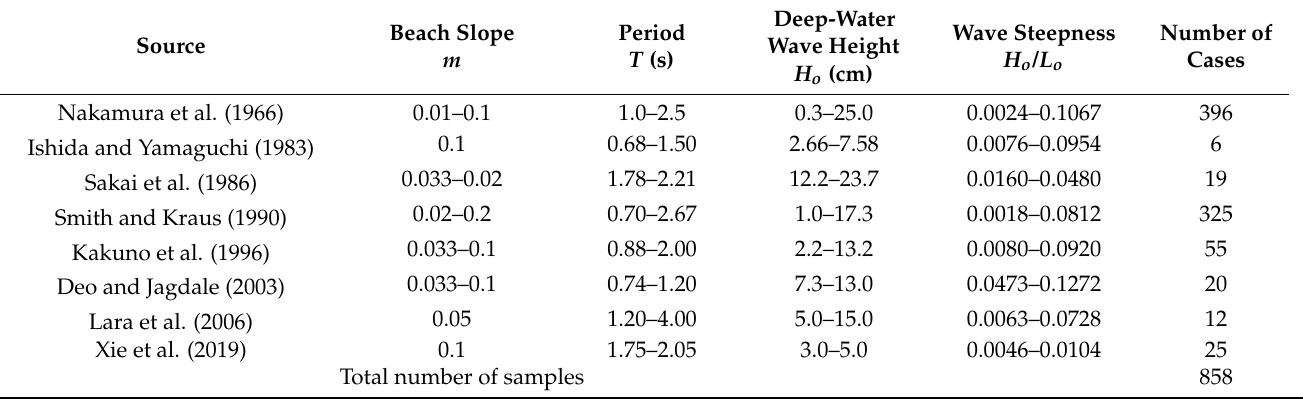
Table 1. Summary of historical experimental data set on breaking waves.